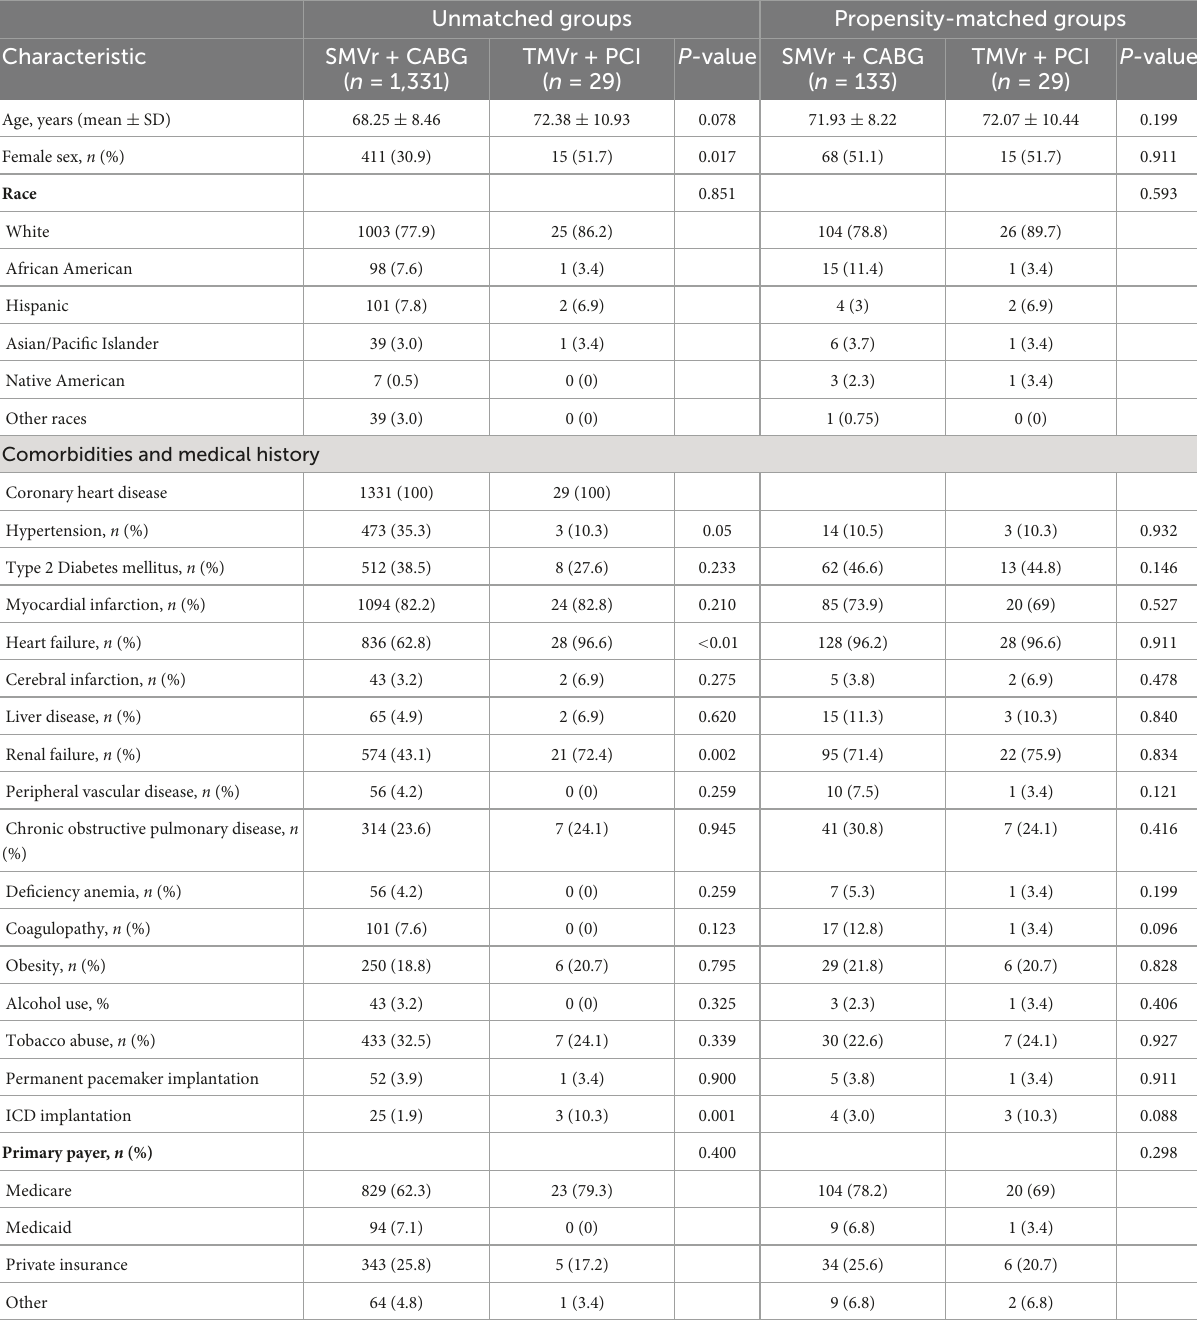
TABLE 1 Basic characteristics of the patients who underwent SMVr + CABG and TMVr + PCI (2016–2018). Unmatched groups Propensity-matched